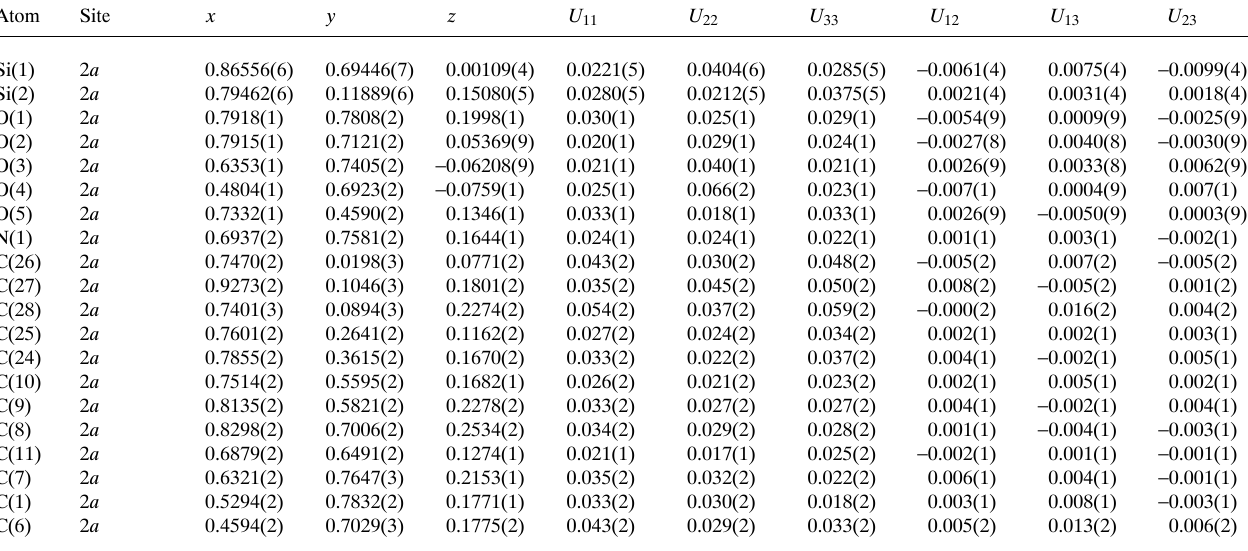
Table 3. A tomic coordin a tes a nd displ a cement p a r a meters (in Å 2 ) .